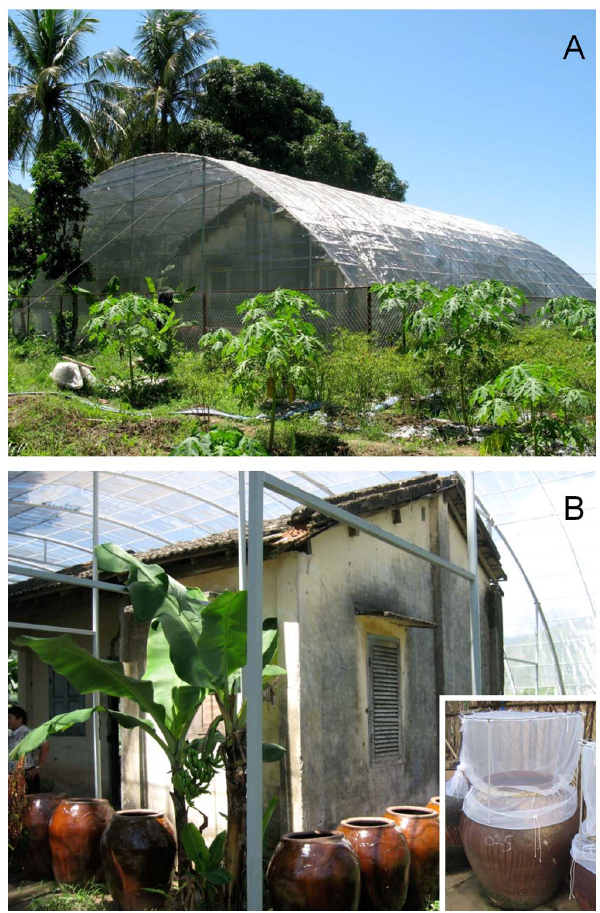
Figure 1. Semi field mosquito habitat for maintaining cohorts of aged Aedesaegypti . A. External view of enclosure. B. Internal view of enclosed house and standard sized earthen-ware ceramic water storage jars during conditioning period. Inset. Emergence traps; placed over each jar as soon as pupae were observed. The numbers of females were observed every 24 hours, and when maximum numbers were obtained from a single 24–48 hour period mosquitoes were released. were released into the field cage (called semi-field free mosquitoes). 400 mosquitoes were placed inside each of three small cages inside the house (called semi-field caged mosquitoes). Pupae from the same cohorts were also used to stock three ‘‘sentinel cages’’ situated in Tri Nguyen village (40 6 40 6 40 cm; 400 pupae per cage). Mosquitoes in the semi-field habitat and small cages were provided access to a human blood source every second day, from day one. Sucrose feeding stations (pads soaked in 10% sucrose solution) were also provided.